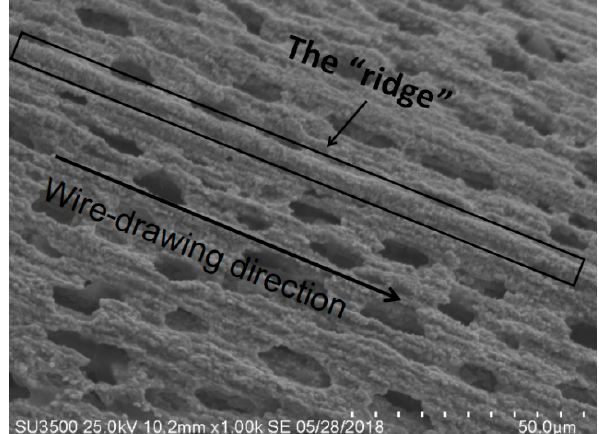
Figure 5. The “ridge” surface morphology of IrRh25.